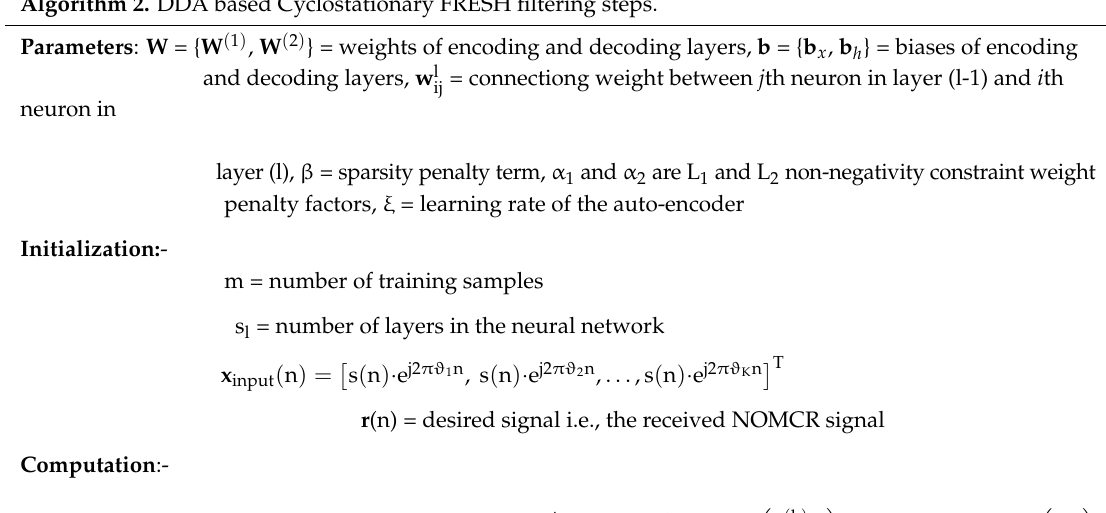
Algorithm 2. DDA based Cyclostationary FRESH filtering steps.